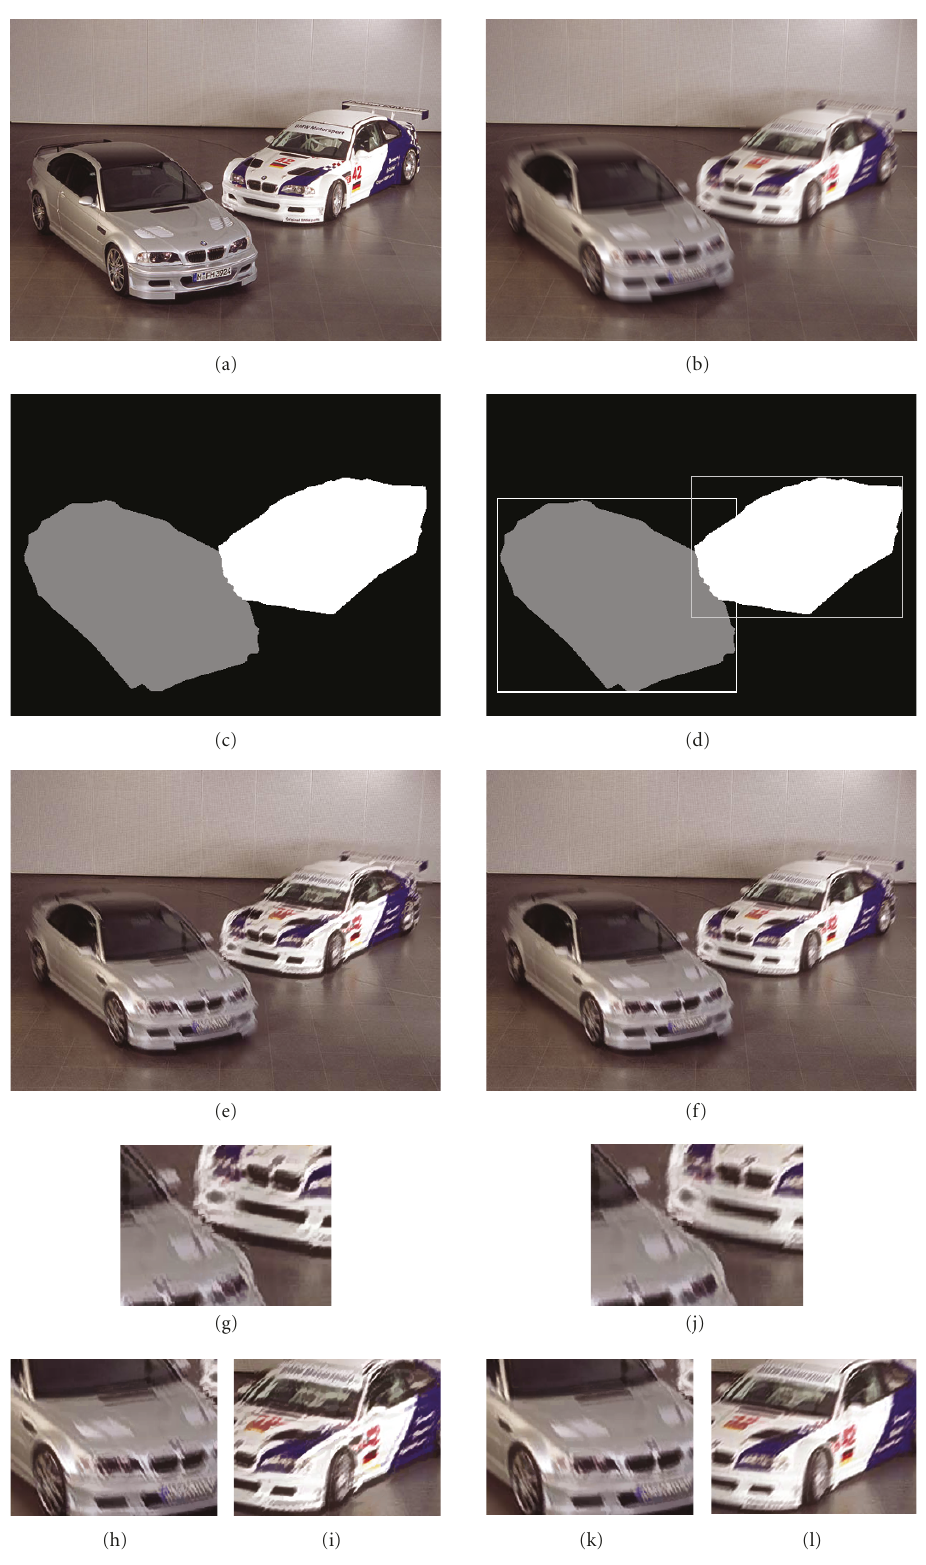
Figure 14: Restoration results on simulated shift variant blur images [7]. (a) Original image. (b) Blurred image. (c) Segmentation result. (d) Segmentation result with rectangular block. (e) Restoration result of [6]. (f) Restoration results of the proposed method. (g)–(i) Magnified region of Figure 14(e). (j)–(l) Magnified region of Figure